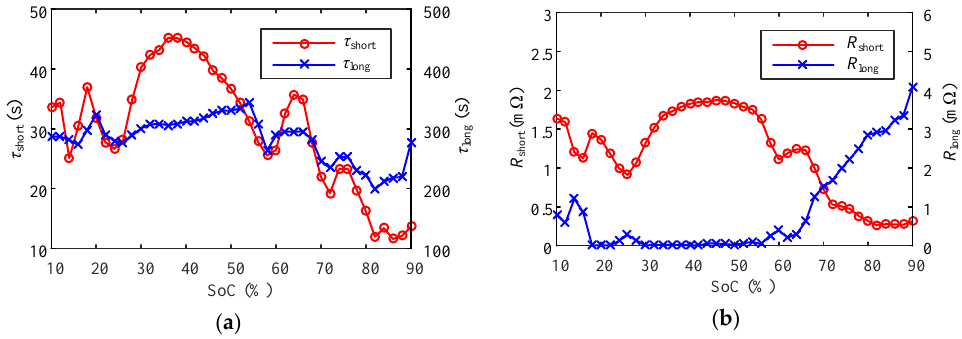
Figure 8. Parameter estimation results for the constant-current (CC) charging scenario: ( a ) time constant; ( b ) resistance.